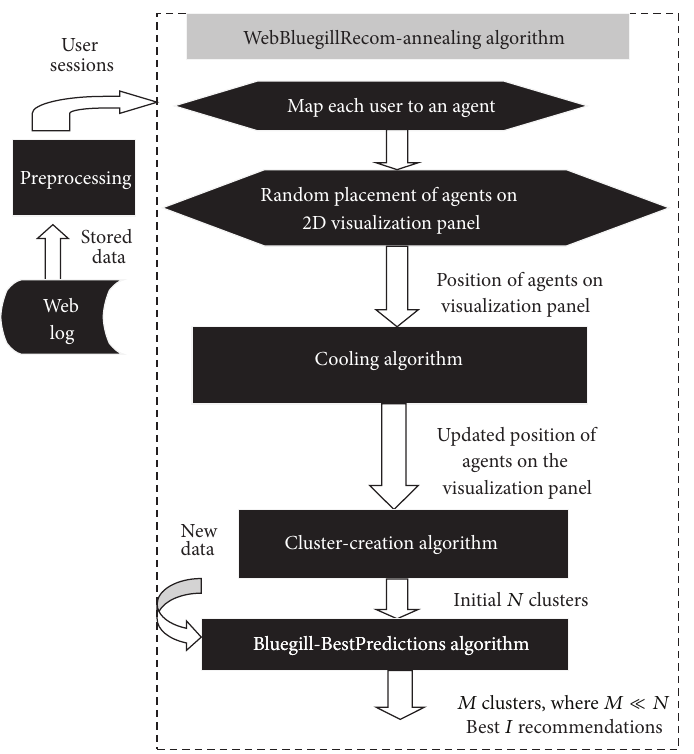
Figure 1: Steps involved in WebBluegillRecom-annealing dynamic recommender